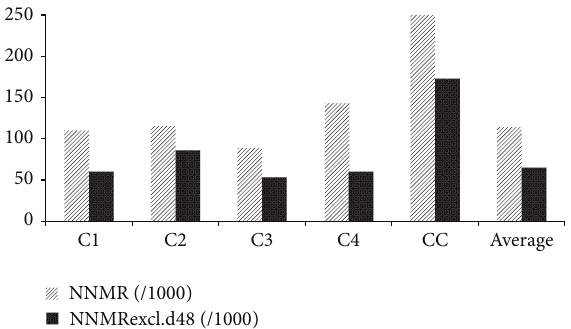
Figure 9: Mortality rate indices. NNMR: neonatal mortality rate; NNMRexcl.d48: neonatal mortality rate without neonates that die within 48 hours of presentation; average was based on the outreach centres.